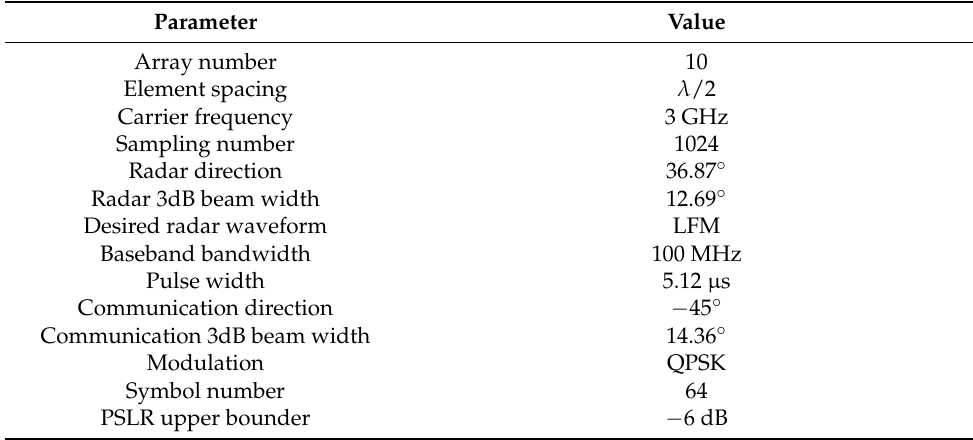
Figure 2. The absolute value of the weighting vector in different directions. Table 1. Simulation